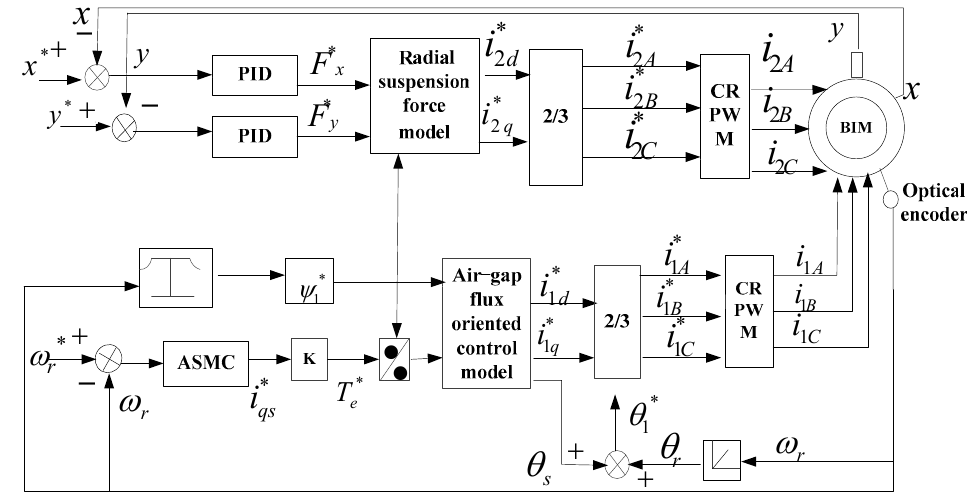
Figure 2. Control diagram of Bearingless Induction Motor (BIM) speed regulation system.